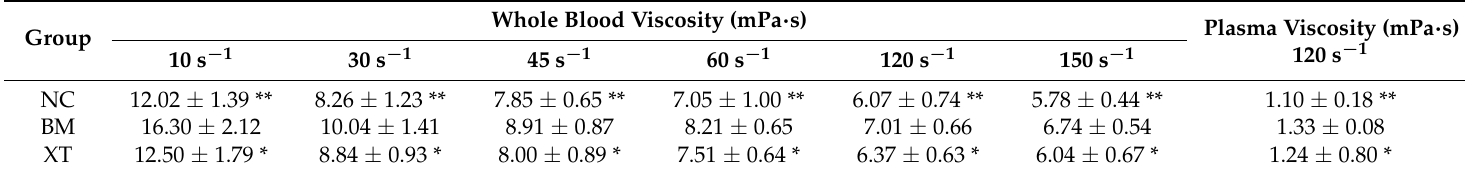
Table 1. Effects of XXT on whole blood and plasma viscosity in rats with BBS.